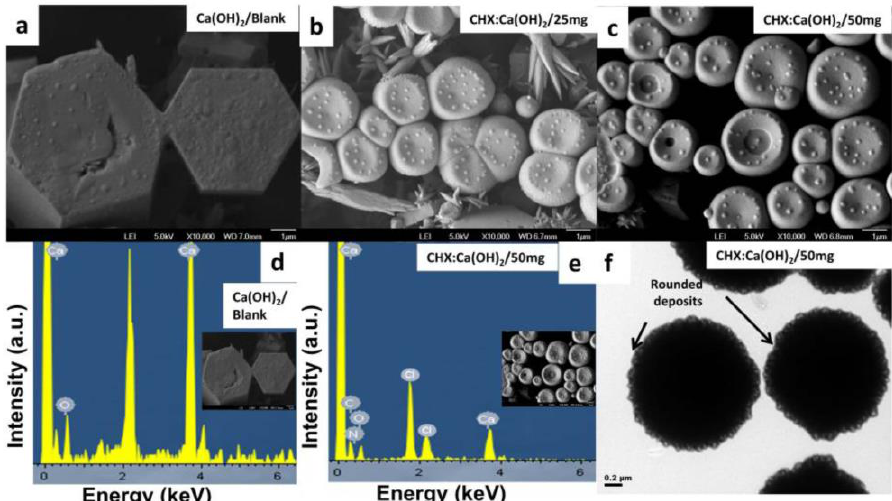
Figure 3. Representative SEM images showing the morphology of ( a ) the unloaded Ca(OH) 2 microparticles [Ca(OH) 2 /Blank]; ( b , c ) the CHX-loaded/Ca(OH) 2 microparticles at the formulations of CHX:Ca(OH) 2 /25 mg and CHX:Ca(OH) 2 /50 mg respectively. Ca(OH) 2 /Blank-microparticles ( a ) were hexagonal in shape; whereas the CHX:Ca(OH) 2 /25 mg ( b ) and the CHX:Ca(OH) 2 /50 mg ( c ) microparticles exhibited spherical shape with distinctly visible “rounded deposits” on the microparticles surface ( d , e ). Representative EDX-SEM elemental-composition spectral characterization of the ( d ) the unloaded Ca(OH) 2 microparticles [Ca(OH) 2 /Blank] showing only the Ca/O signals confirmed the presence of Ca(OH) 2 in their structure and ( e ) the CHX:Ca(OH) 2 /50 mg displaying the presence of the elements chlorine, nitrogen and carbon, confirmed the presence of these elements constituting CHX, apart from the Ca/O signals which again substantiated the presence of Ca(OH) 2 . ( f ) Selected high magnification TEM image of the CHX:Ca(OH) 2 /50 mg microparticles confirming the spherical morphology and the prominent “rounded-deposits” seen evenly distributed on the surface of microparticles.